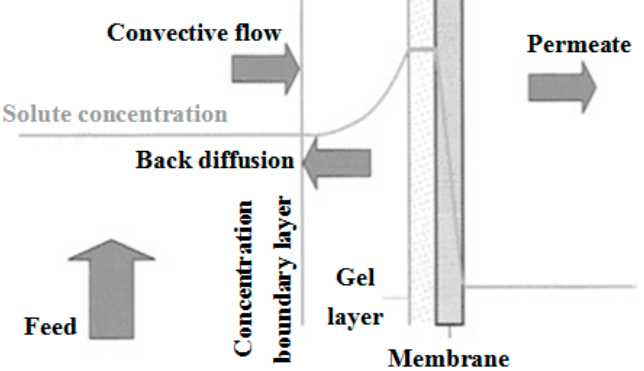
Figure 1. Concentration polarization. Reproduced with permission from Reference